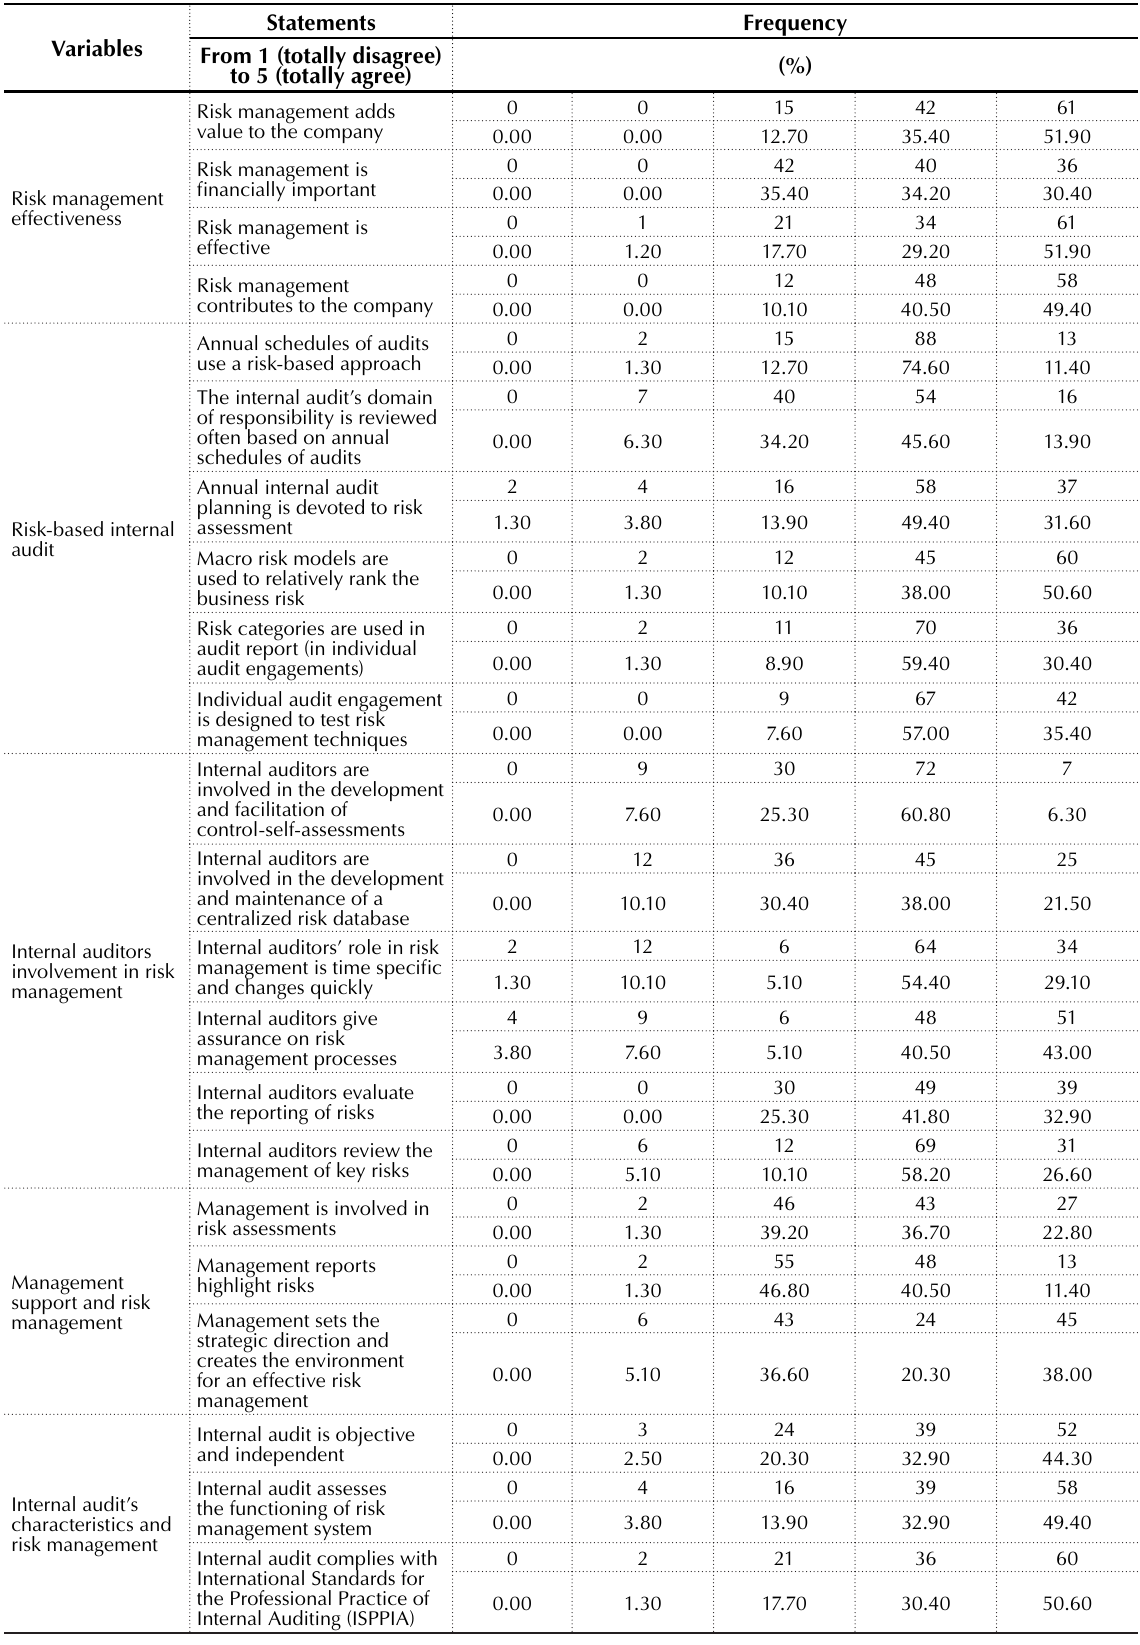
Table 2. Descriptive statistics regarding dependent and independents